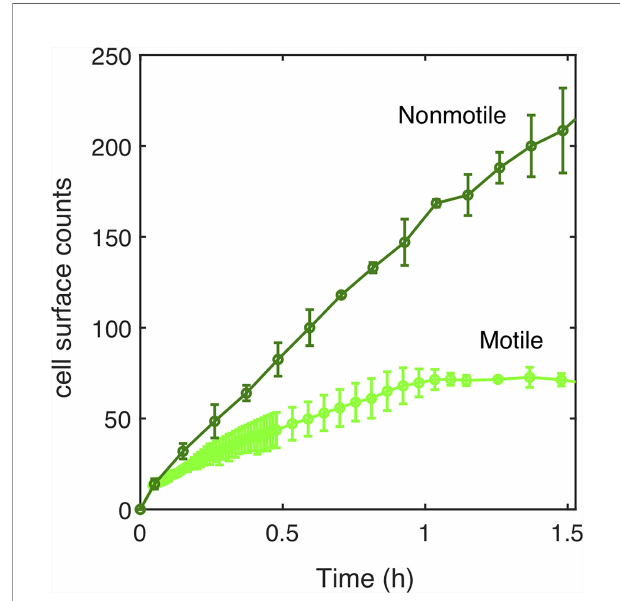
FIGURE 3 | Surface access experimental kinetics of nonmotile and motile cells. The number of cells reaching the surface over the incubation time (90 min) has been determined experimentally for motile (light green curve) and nonmotile (dark green curve). 1.6x10 6 cells/ml were injected in MB medium at time t=0. The surface was regularly imaged to count the settled cells. Errors bars are standard deviation over 3 different